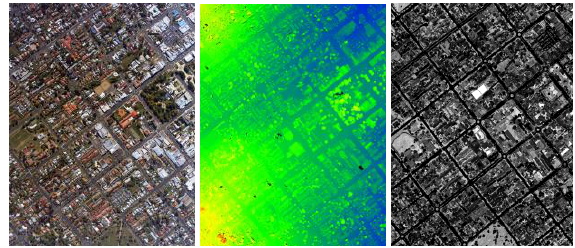
Figure 1. Aerial image (left), colour-coded LiDAR DSM (middle) and LiDAR intensity image